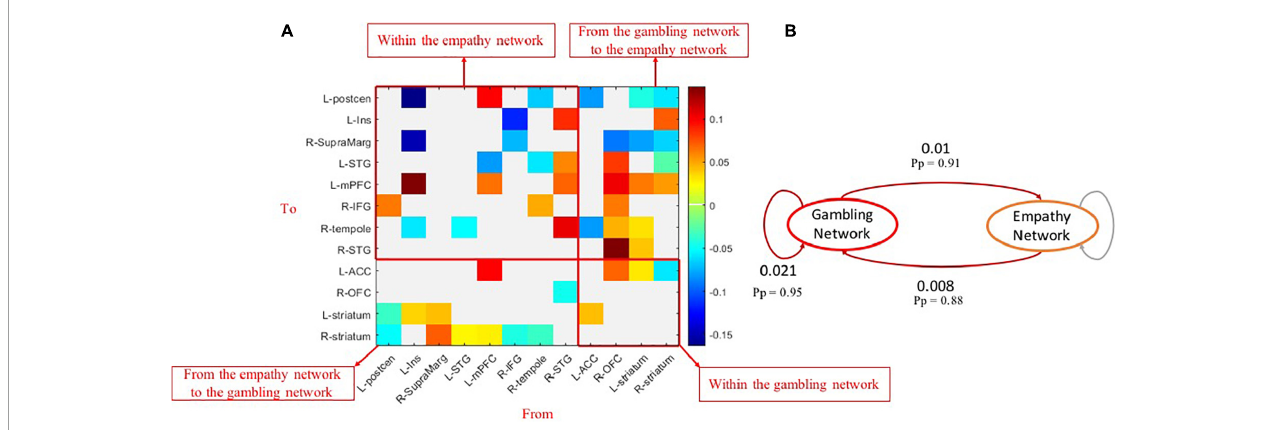
FIGURE4 Group-different effects of effective connectivity among empathy and gambling networks. (A) The causal connections revealing group differences ( Pp > 0.90) among brain nodes of empathy and gambling networks; (B) the network-level group differences of causal connections among empathy and gambling networks. Pp , posterior